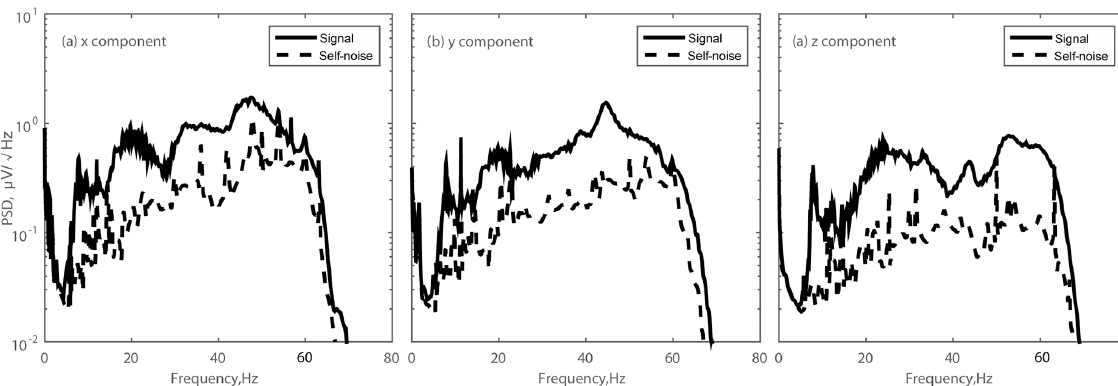
Figure 10. Power spectral density (PSD) of the signal and self-noise in real environmental conditions from the OBEMS at test site R21. (a) First horizontal component, (b) second horizontal component, and (c) vertical geophone